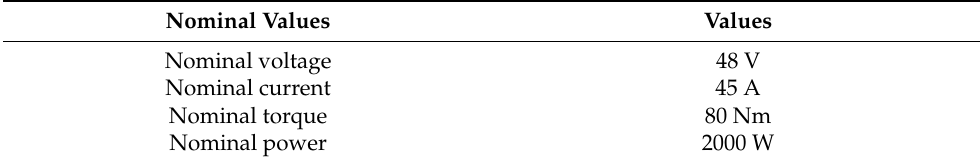
Table 1. Motor nominal